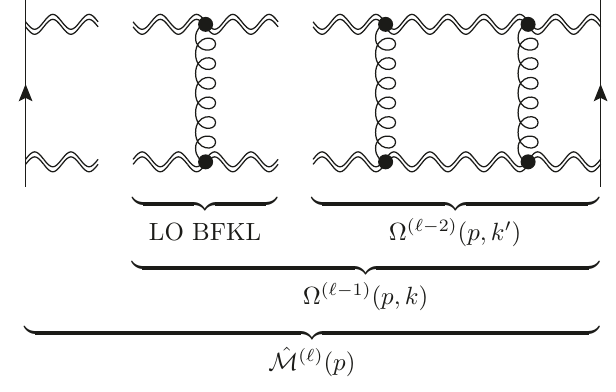
Figure 2 . Graphical representation of the amplitude at NLL accuracy, as obtained through BFKL evolution. The addition of one rung corresponds to applying once the leading-order BFKL evolution onto the projectile wavefunction or impact factor at order ( ‘ (cid:0) 2). This gives the wavefunction at order ( ‘ (cid:0) 1), according to eq. (2.18). Closing the ladder and integrating over the resulting loop momentum gives the reduced amplitude, according to eq.